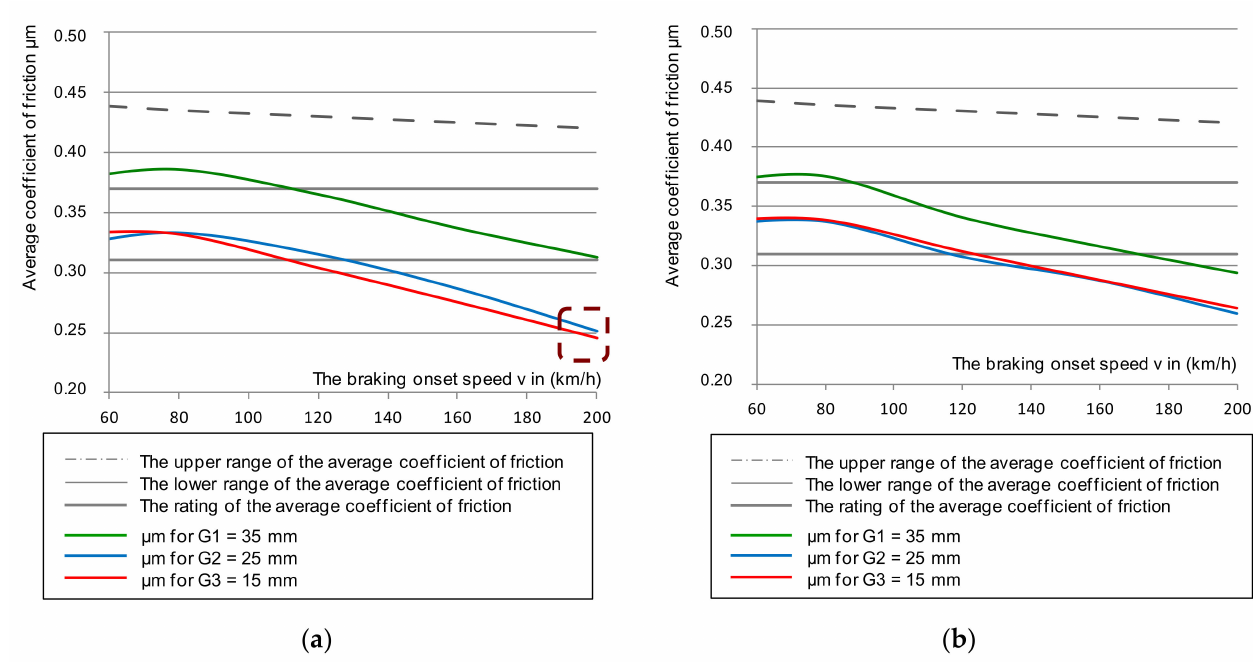
Figure 7. Characteristics of the average coefficient of friction µ m on the braking initiation speed with a pressure of 36 kN and mass per disc of 4.7 t: ( a ) for a classic disc, ( b ) for a disc perforated on the friction